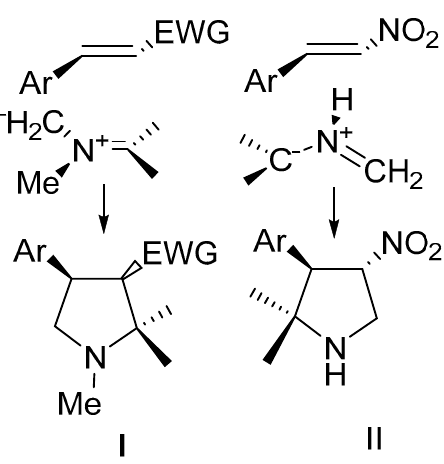
Scheme 1. Cycloaddition of azomethine ylides.